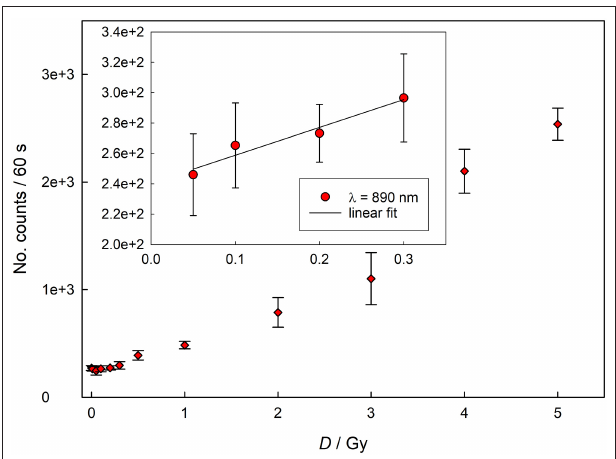
FIGURE 2 | Dose response for infrared (890nm) stimulation (data acquired with Reader 1).